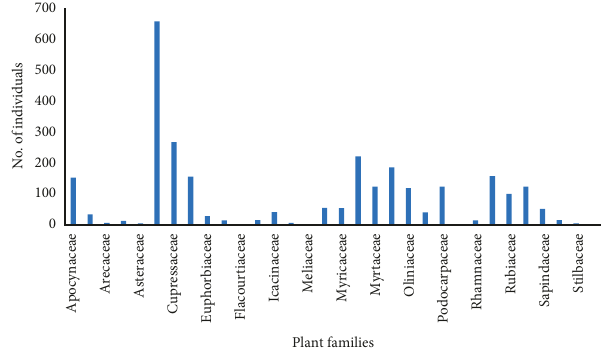
Figure 2: Distribution of the plant family in the Gennemar dry Afromontane